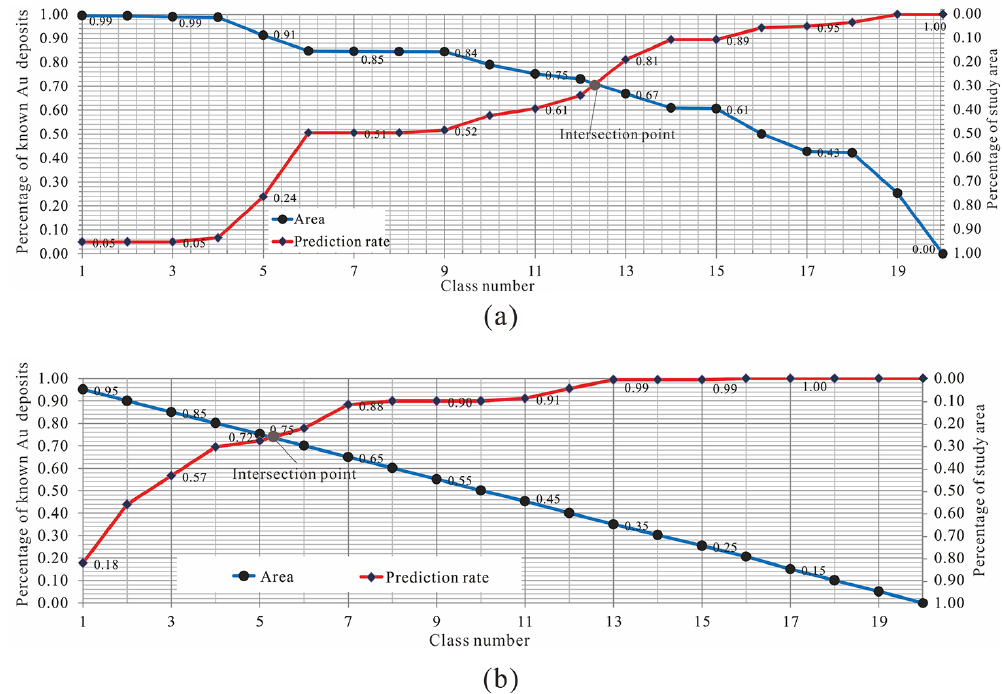
Figure 10. Prediction–area (P-A) plots for discretized posterior probability maps obtained by logistic regression and